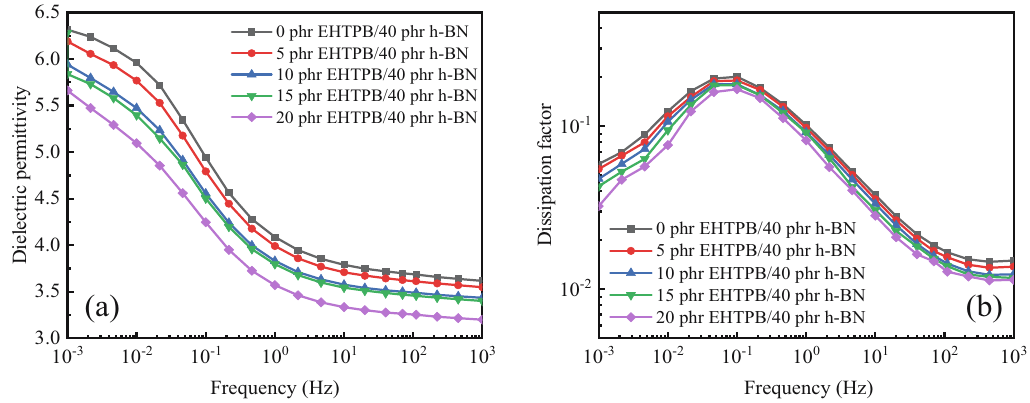
Figure 14: Dielectric permittivity and dissipation factor of EP/h - BN/EHTPB composites. ( a ) Dielectric permittivity, ( b ) dissipation factor.